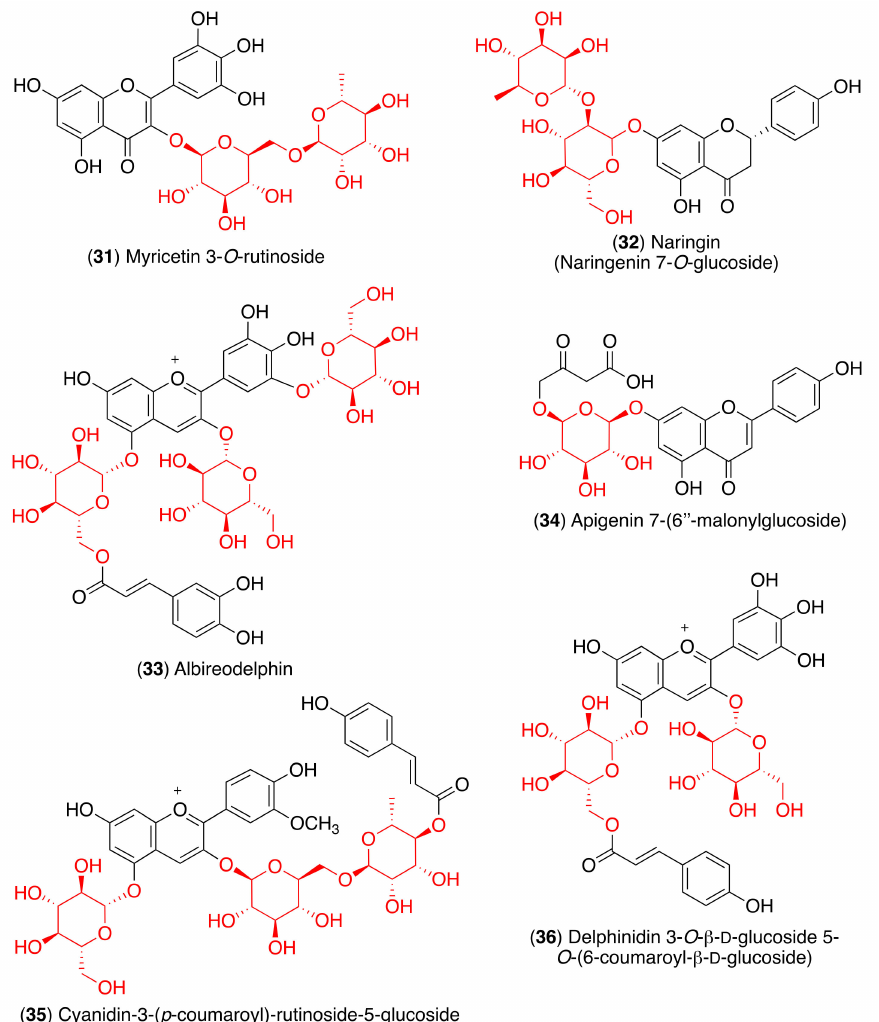
Figure 7. Anti-coronaviral glycosyl